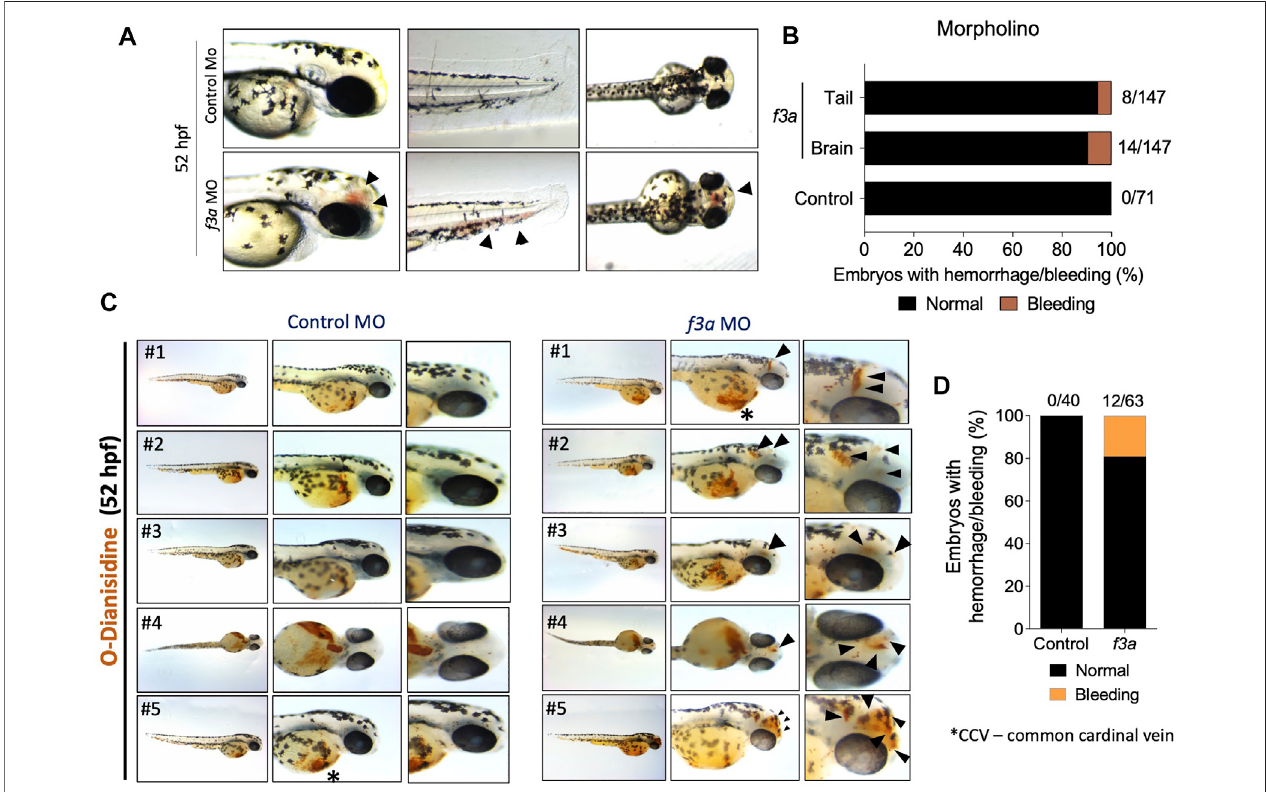
FIGURE4| f3a knockdownshowsbleedingphenotype: (A) Lateralanddorsalviewsofhead,andlateralviewoftailinliveembryos.Thearrowsdepictbrainandtail bleeding at 52 hpf and (B) quanti fi cation of the same. Numbers in the bars represent the ratios used to calculate the percentages. (C) Bright- fi eld images of zebra fi sh embryos stained with O-dianisidine (OD) and imaged at 48 hpf. Black arrows indicate sites where abnormal accumulation of hemoglobinized blood was detected in the head region (controlMO and f3a MO). (D) Percentage of cerebral hemorrhage in embryos at 52 hpf. Numbers in the bars represent the ratios used to calculate the percentages. Data were pooled from three independent